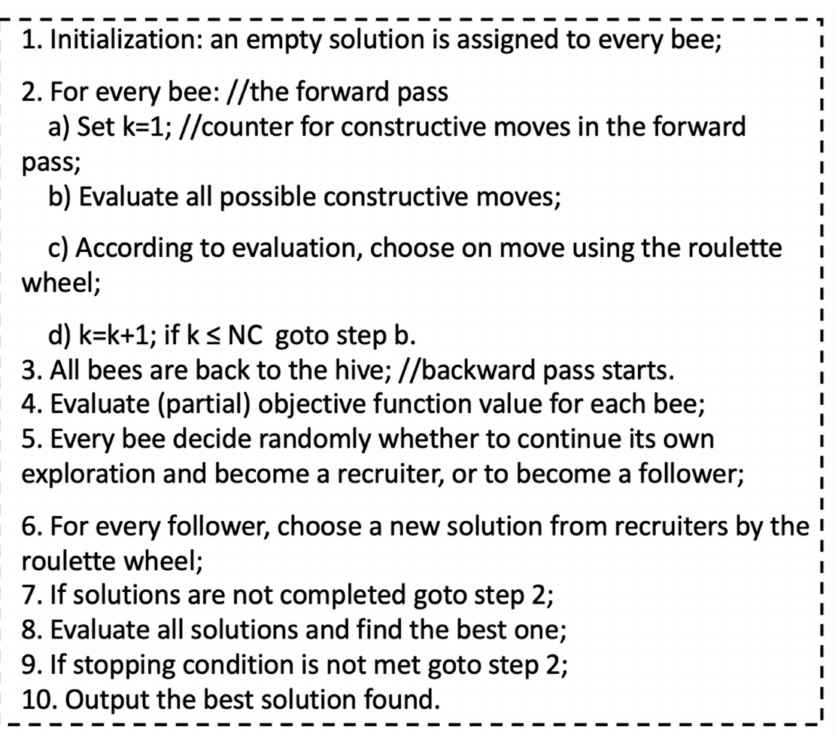
Figure 18. Sequential steps of the BCO